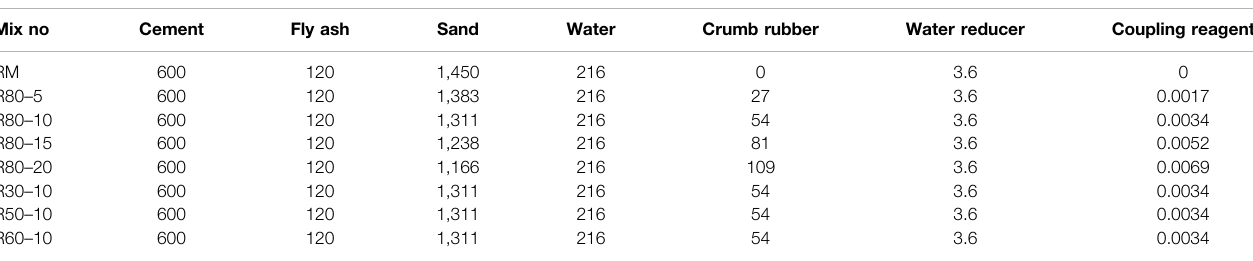
TABLE 2 | The mixture proportion of CRM (kg/m 3